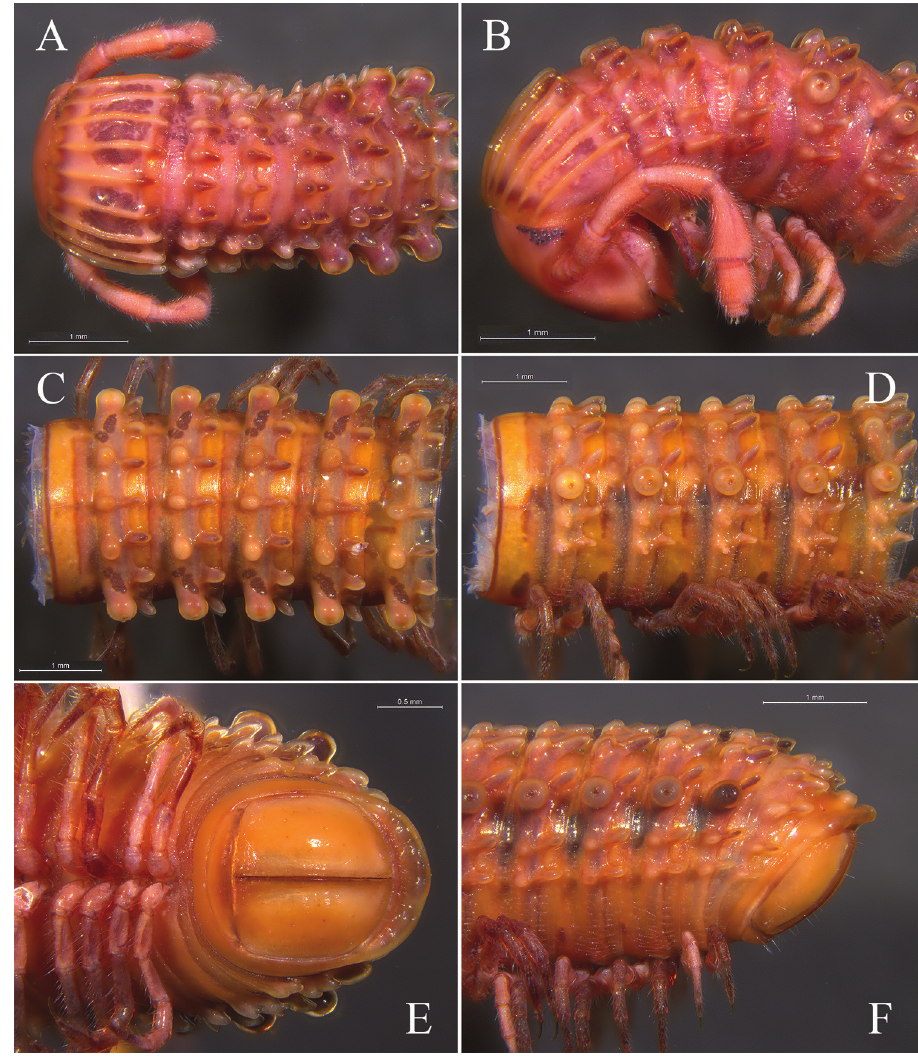
Figure 7. Glyphiulus calceus sp. n . , holotype. A anterior part of body, dorsal view B same, lateral view C mid- body segments, dorsal view D same, lateral view E posterior part of body, ventral view F same, lateral